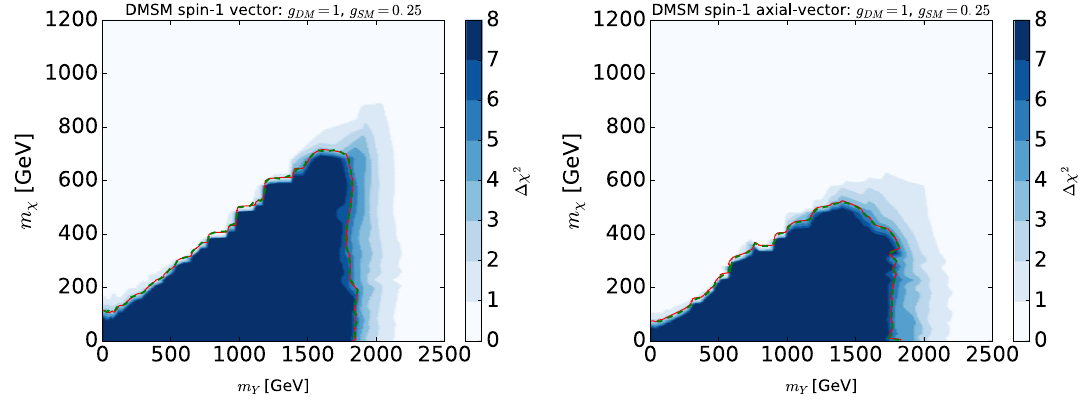
Fig. 2 The likelihoods for our implementations (16) (colours and solid red lines) of the CMS monojet constraints [75] (dashed green lines) for a spin-one mediator having (left panel) vector-like couplings and (right panels) axial couplings to quarks and DM particles